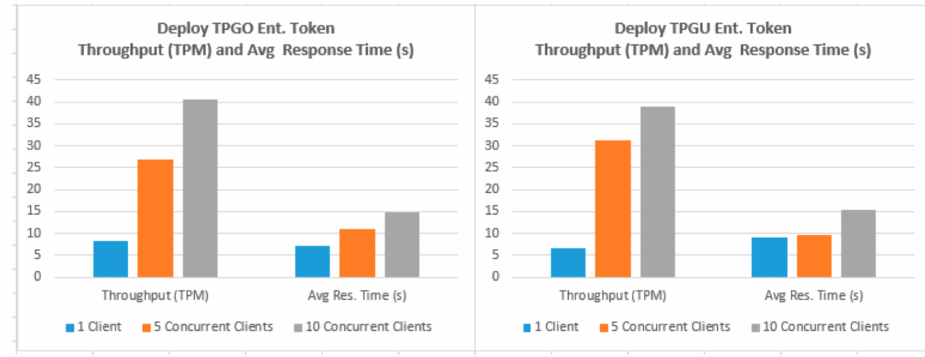
Figure 20. Throughput (TPM) vs. Average Response Time (s) for Deploy Token Functions.